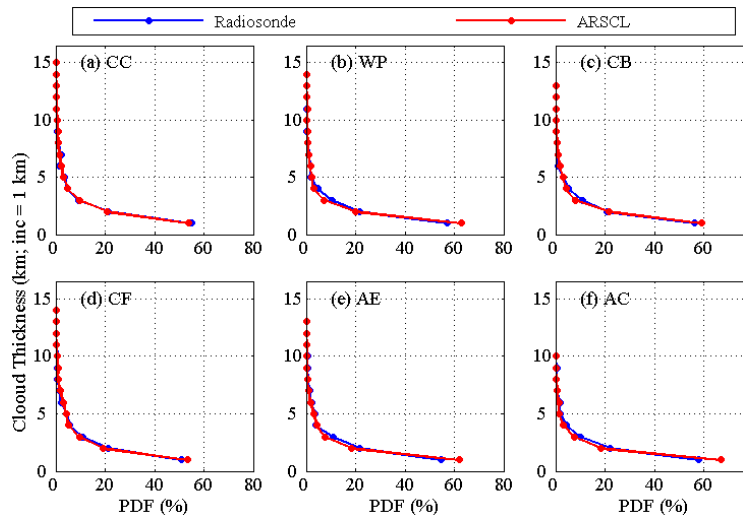
Figure 13. PDF of cloud thickness derived from radiosonde (blue line) and ARSCL (red line) in the synoptic patterns of: CC ( a ); WP ( b ); CB ( c ); CF ( d ); AE ( e ); and AC ( f ) during 2001–2010 at the SGP site. The space interval is 1 km in each panel.